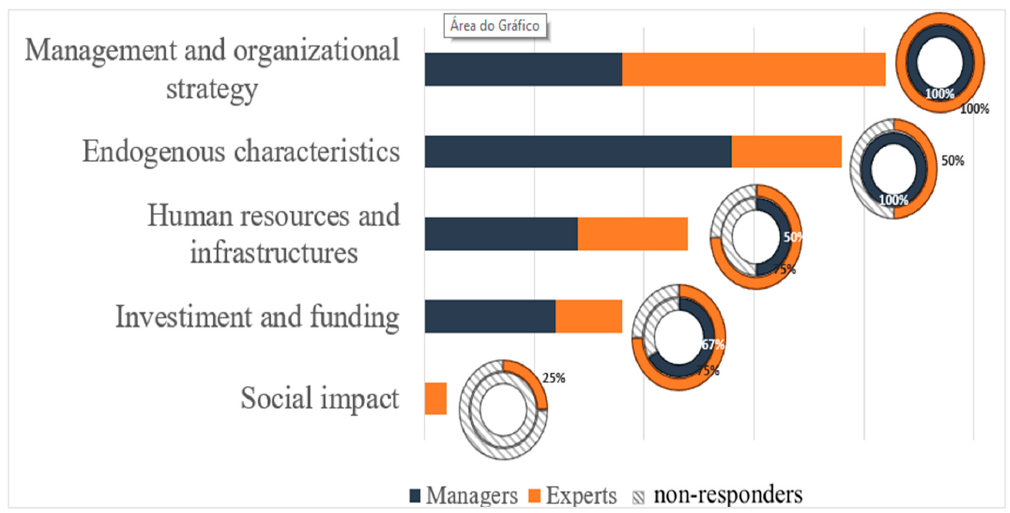
Figure 6. Perception of respondents (Managers and Experts) about the barriers to implementing I4.0 in the biopharmaceutical sector—Bar graph: quantity (number) of references; pie chart: % by category of total respondents who mentioned barriers.